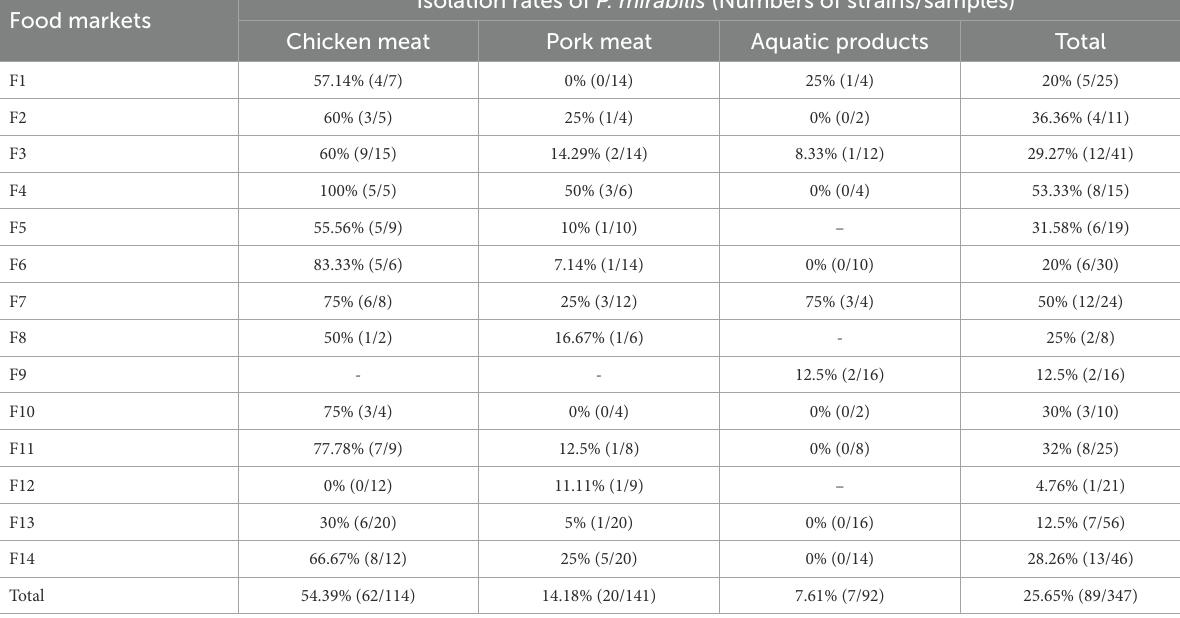
TABLE 1 Isolation rates of P. mirabilis in 14 food